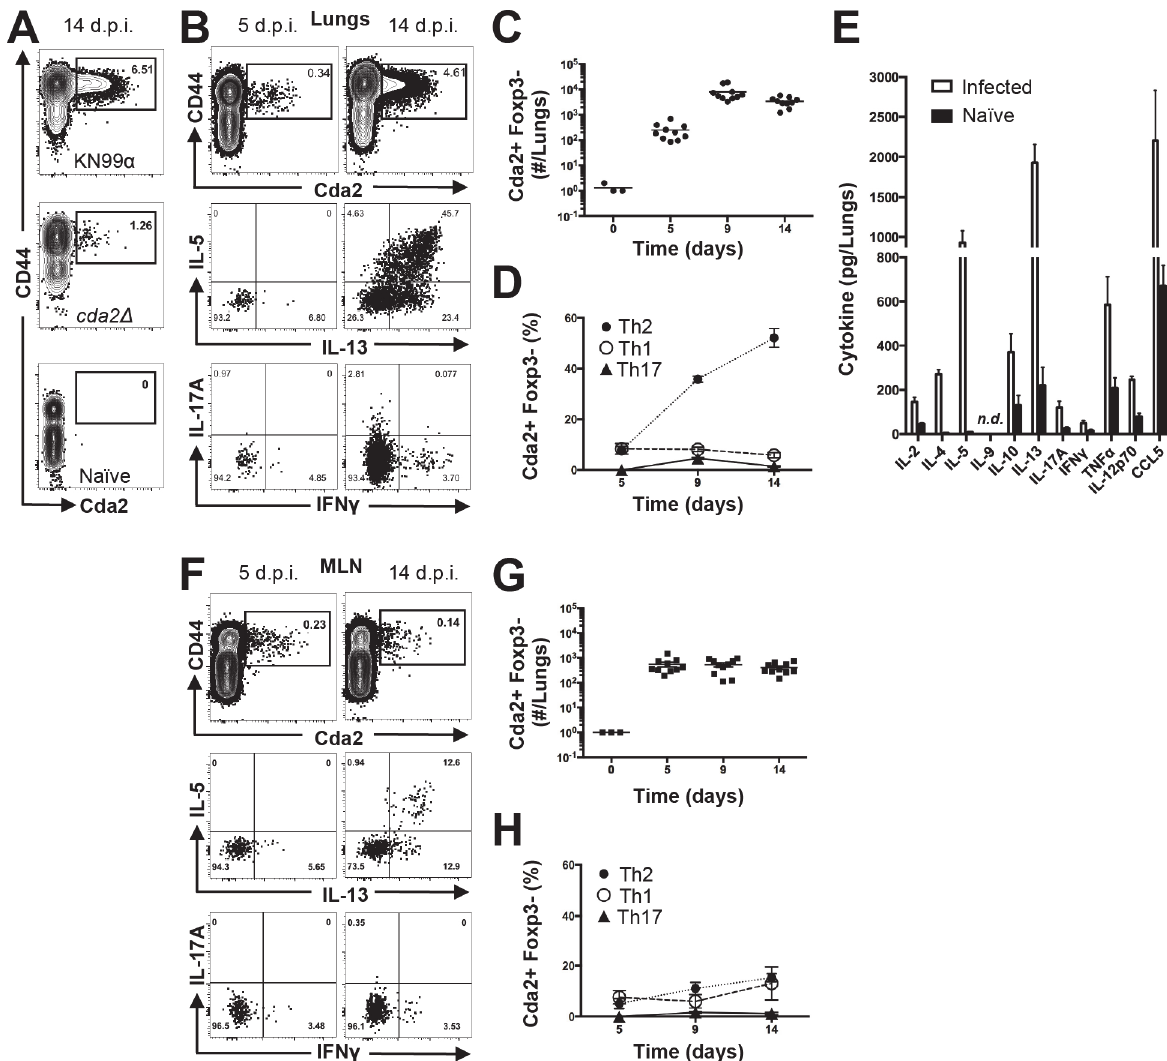
Fig 1. Type-2 Helper T Cells Accumulate in the Lungs of Mice Infected with C. neoformans . ( A ) Cda2-MHCII tetramer identifies C. neoformans -specific helper T (Th) cells from mice 14 days post-infection with strain KN99 α , cda2 Δ , or age-matched, na ï ve mice. Flow cytometry plot ( B ) or graphs ( C&D ) from lung digests showing CD4+, Foxp3-, CD44+ Cda2+ Th cells expressing Th1 (IFN γ ), Th2 (IL-5 & IL-13), or Th17 (IL-17A) cytokines. ( E ) Cytokines from lung homogenates 14 days post-infection with KN99 α or age-matched, na ï ve mice. Flow cytometry plot ( F ) and graphs ( G&H ) from mediastinal lymph node suspensions of Th cells expressing Th1, Th2, or Th17 cytokines. Data are presented as mean +/- standard error with 2 independent experiments of at least 5 mice per group. Cda = Chitin deacetylase, CCL = chemokine ligand, IFN = interferon, IL = interleukin, MLN = mediastinal lymph node, TNF = tumor necrosis